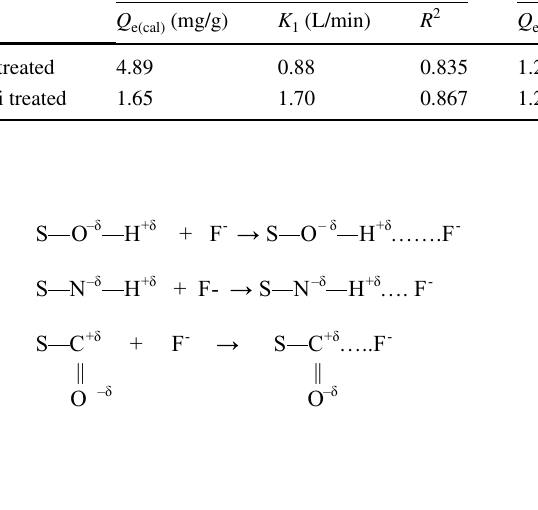
Table 6 Kinetics of pseudo-first-order and pseudo second order of the two adsorbents studied Adsorbents Pseudo first order Pseudo second